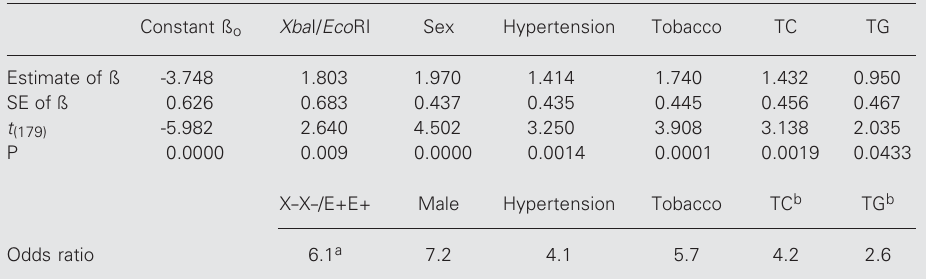
Table 6. Results of the Student t -test and the odds ratios obtained by multivariate logistic regression analysis, considering CAD as the dependent variable and Xba I/ Eco RI genotypes, sex, hypertension, tobacco consump- tion, total cholesterol (TC) and triglycerides (TG) as independent variables in CAD+ (N = 108) and CAD- (N = 78)